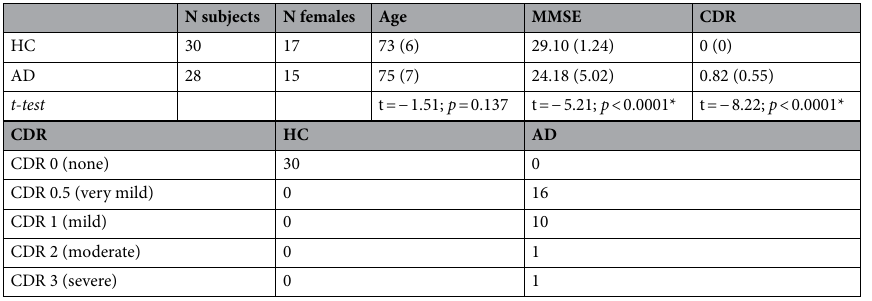
Table 1. Group demographics with MMSE and CDR scores. *Student t-test demonstrated differences in MMSE and CDR between AD and HC